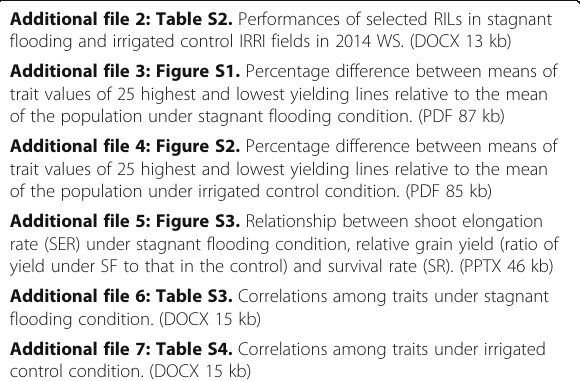
Additional file 2: Table S2. Performances of selected RILs in stagnant flooding and irrigated control IRRI fields in 2014 WS. (DOCX 13 kb) Additional file 3: Figure S1. Percentage difference between means of trait values of 25 highest and lowest yielding lines relative to the mean of the population under stagnant flooding condition. (PDF 87 kb) Additional file 4: Figure S2. Percentage difference between means of trait values of 25 highest and lowest yielding lines relative to the mean of the population under irrigated control condition. (PDF 85 kb) Additional file 5: Figure S3. Relationship between shoot elongation rate (SER) under stagnant flooding condition, relative grain yield (ratio of yield under SF to that in the control) and survival rate (SR). (PPTX 46 kb) Additional file 6: Table S3. Correlations among traits under stagnant flooding condition. (DOCX 15 kb) Additional file 7: Table S4. Correlations among traits under irrigated control condition. (DOCX 15 kb)